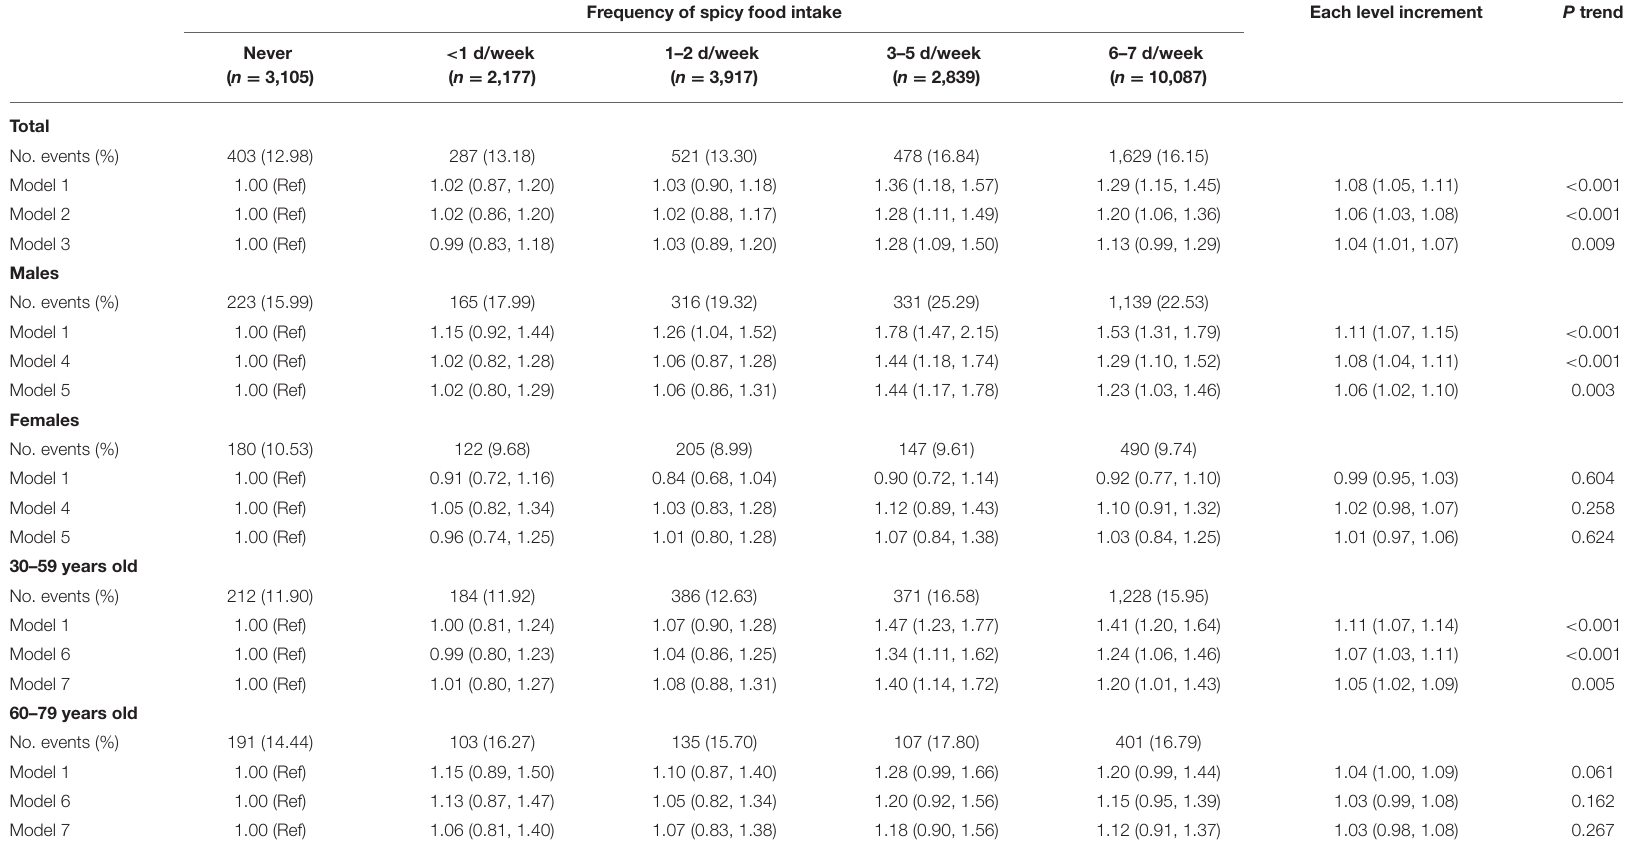
TABLE 2 | Multivariable-adjusted associations (ORs and 95% CIs) between frequency of spicy food consumption and risk of hyperuricemia ( N = 22,125). Frequency of spicy food intake Each level increment P